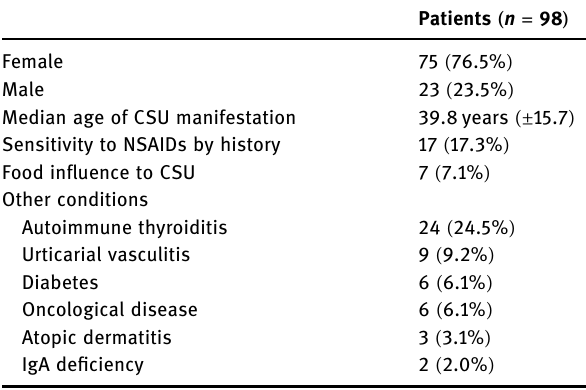
Table 1: Characteristics of 98 CSU patients treated with plasmapheresis